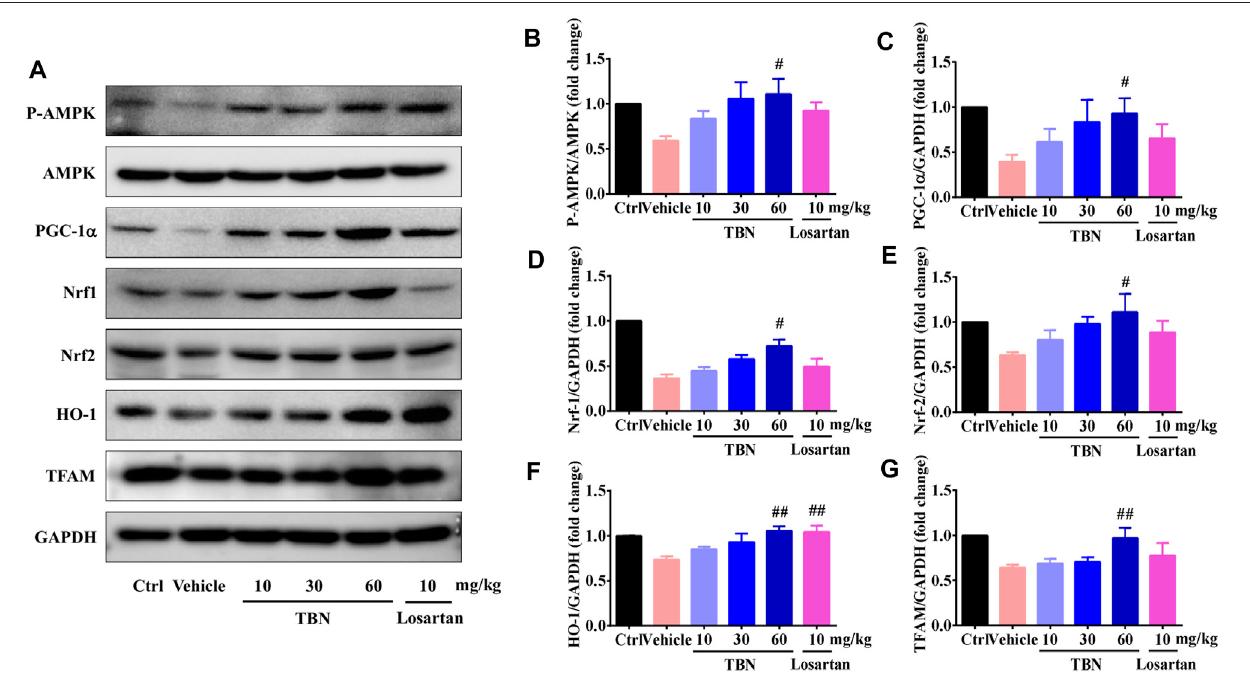
FIGURE 7 | TBN upregulated p -AMPK, PGC-1 α , Nrf1, Nrf2, HO-1, and TFAM expression in both STZ-induced rats. (A) Representative Western blots illustrating the expression of p -AMPK, total AMPK, PGC-1 α , Nrf1, Nrf2, HO-1, and TFAM in the renal cortices of STZ-induced rats. Bar graphs showing mean Western blot of p -AMPK/AMPK ( B ), PGC-1 α /GAPDH ( C ), Nrf1/GAPDH ( D ), Nrf2/GAPDH ( E ), HO-1/GAPDH ( F ), and TFAM/GAPDH ( G ) in the renal cortices of STZ-induced rats. Data aremeans ± SEMofsixratspergroup.Signi fi cancewasdeterminedbyone-wayANOVAfollowedbyTukey ’ stest.* p < 0.05and** p < 0.01vs.Ctrlgroup. # p < 0.05 and ## p < 0.01 vs. vehicle treated-STZ model